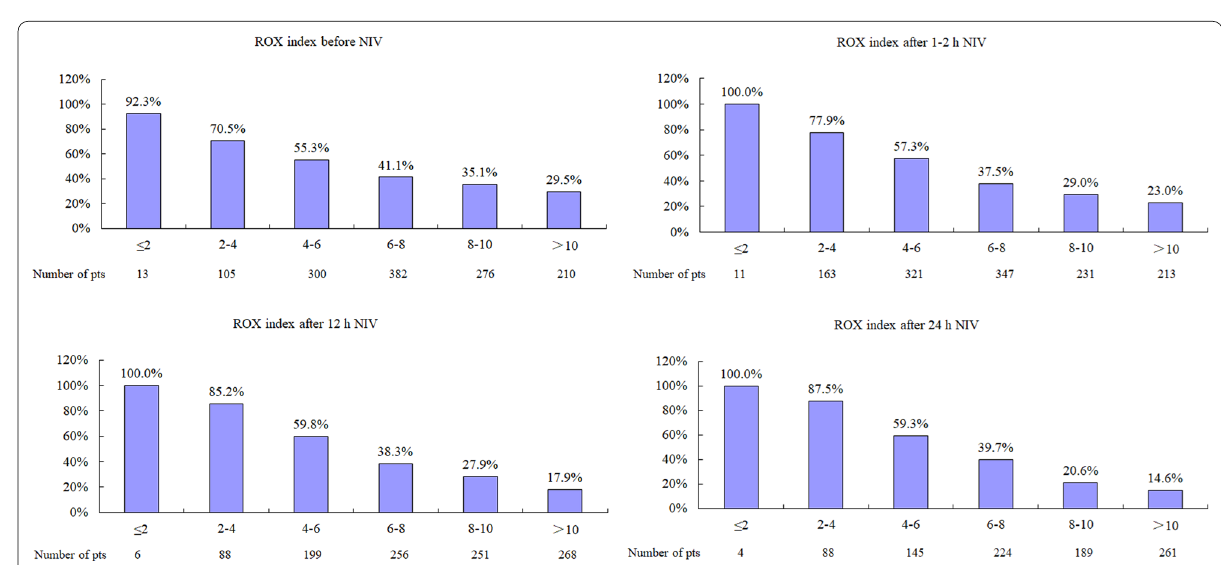
Fig. 3 Rates of NIV failure in patients with different ROX index. ROX SpO 2 /FiO 2 to respiratory rate, NIV noninvasive